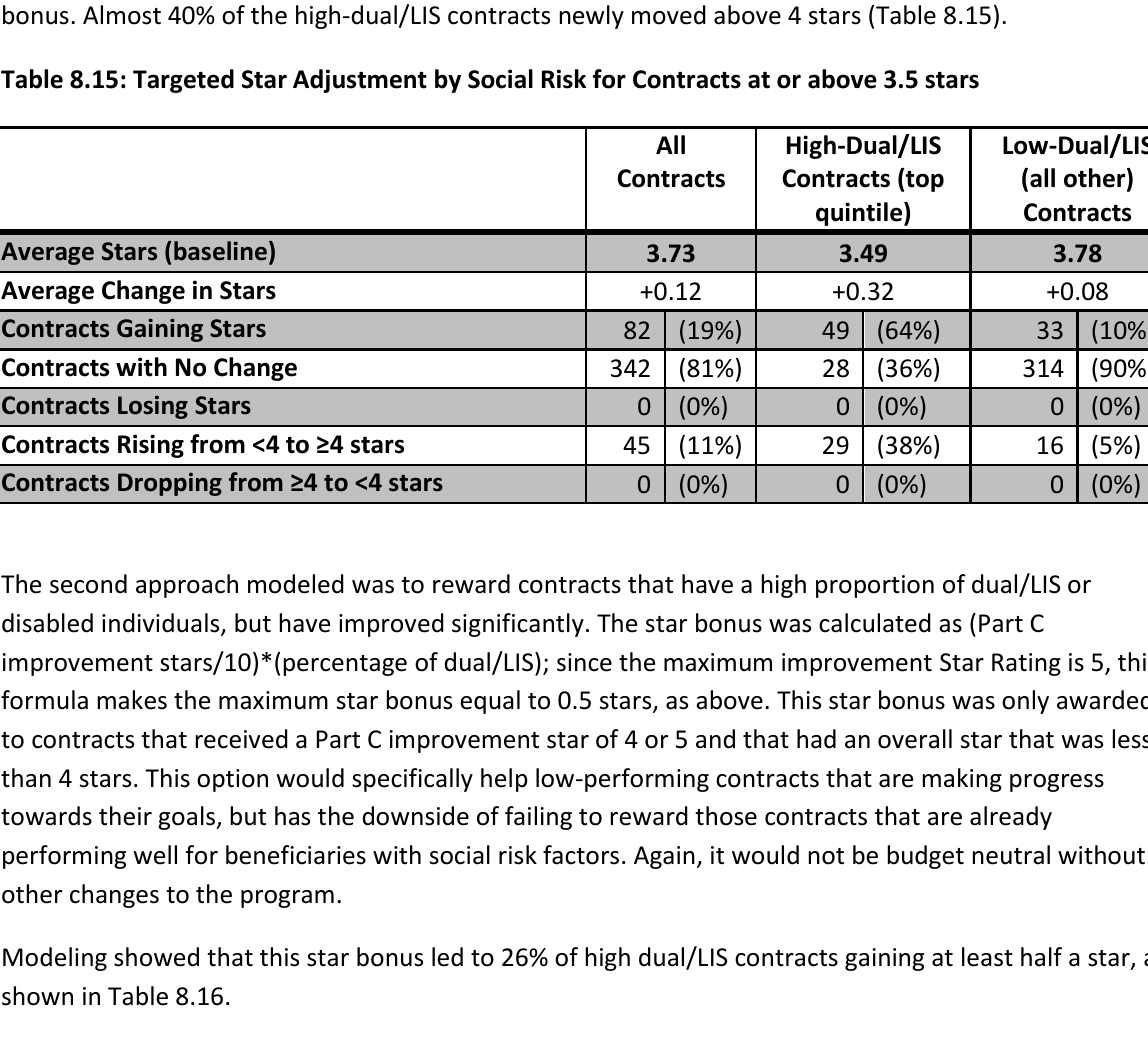
Table 8.15: Targeted Star Adjustment by Social Risk for Contracts at or above 3.5 stars